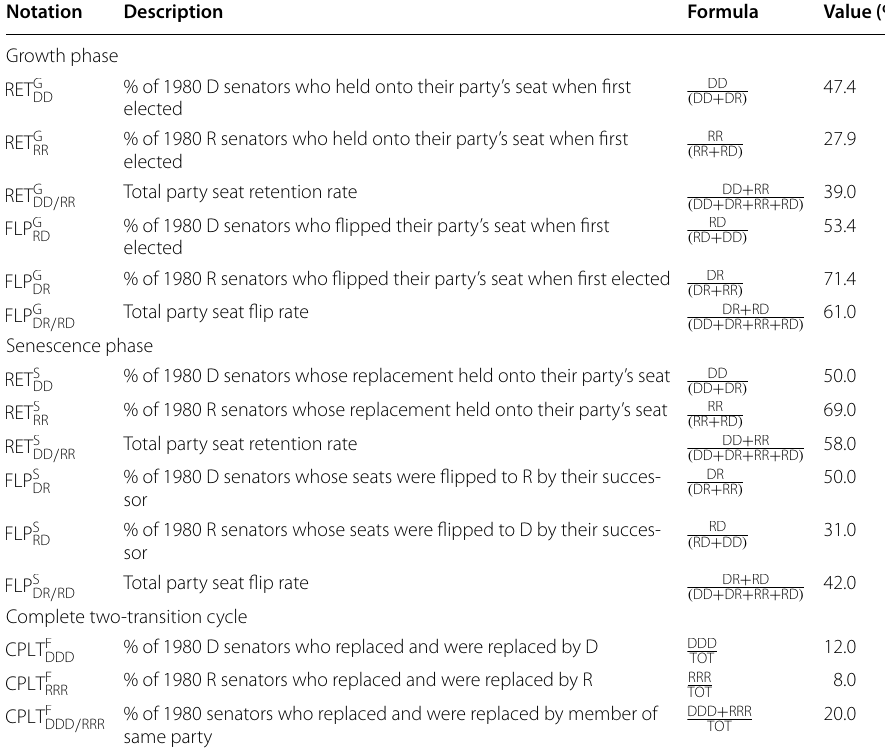
Table 2 Transition metrics during growth and senescence phases for 100% turnover of the 100 members of the 1980 U.S.